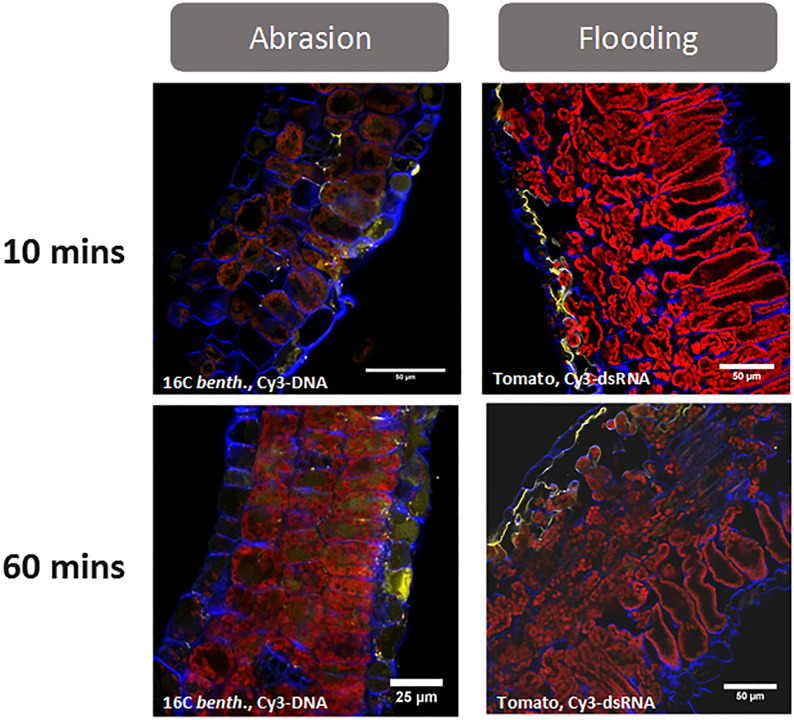
Uptake of fluorescently labeled (Cy3) nucleic acids (dsDNA-1 and siRNA-1 are GFP sequences, see Supplementary Table S1 for sequence information) after foliar application with either abrasion (N. benthamiana) or abaxial stomatal flooding (tomato). Leaf cross sections were collected at 10- and 60-min post application and visualized by confocal microscopy. The images show that both abrasion and abaxial stomatal flooding facilitate transcuticular movement of the applied nucleic acids within 10 min of treatment. Most of the Cy 3-labeled nucleic acids (yellow colored) can be found at the cells adjacent to the site of application and in the apoplast. While the difference between Cy3 and Cy3-labeled nucleic acid cannot be determined using a traditional confocal microscope, hyperspectral confocal fluorescence microscopy (Pedroso et al., 2009) was used in previous validation studies to confirm the yellow signal was due to Cy3 -labeled nucleic acid (unpublished Bayer Crop Science research). Abrasion was conducted using 0.5 mg.ml–1 Cy3-dsDNA–1 in water, 10 μl.leaf–1 and abraded with a 600-grit sandpaper. The stomatal flooding method is described in Supplementary Figure S2. For microscopy, a 5 mm punch from treated leaves was infiltrated in 4% paraformaldehyde/l×PBS followed by sucrose equilibration (10, 20, and 30% in l×PBS for 2–3 h each). Blue fluorescence represents cell wall, and red fluorescence is from chlorophyll.